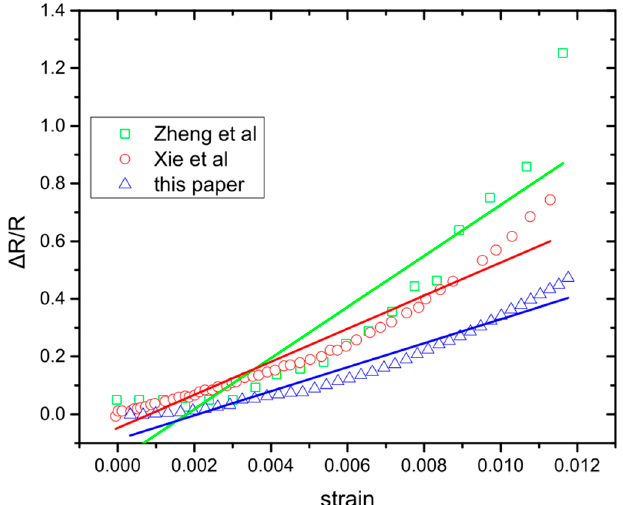
Figure 5. Relative resistance change over strain for different strain sensors based on sputtering deposited NPs. Zheng et al. [35] Cr NPs -based sensor, Xie et al. [36] Pd NPs -based sensor and this paper with Pt NPs. The colour lines are the fitting of Equation (4).